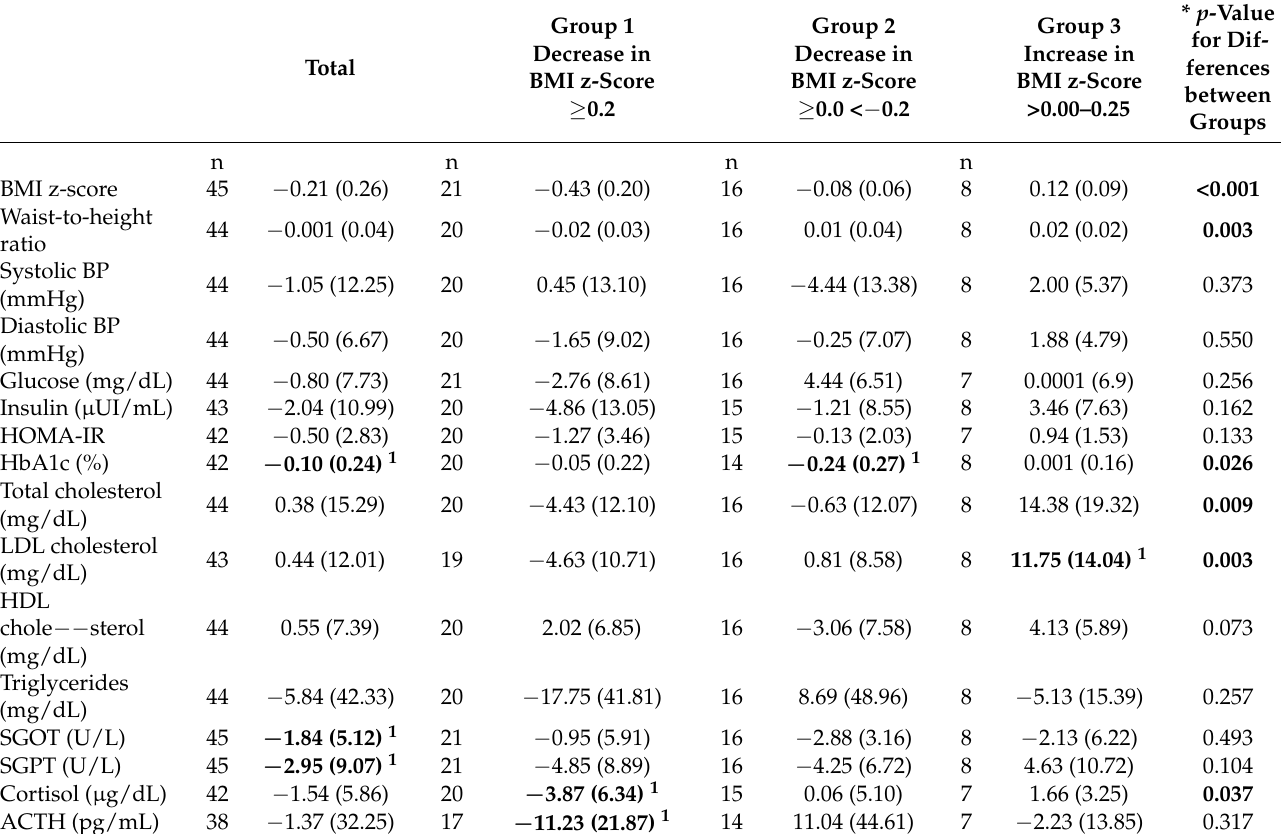
Table 4. Changes in cardiometabolic parameters of children according to BMI z-score